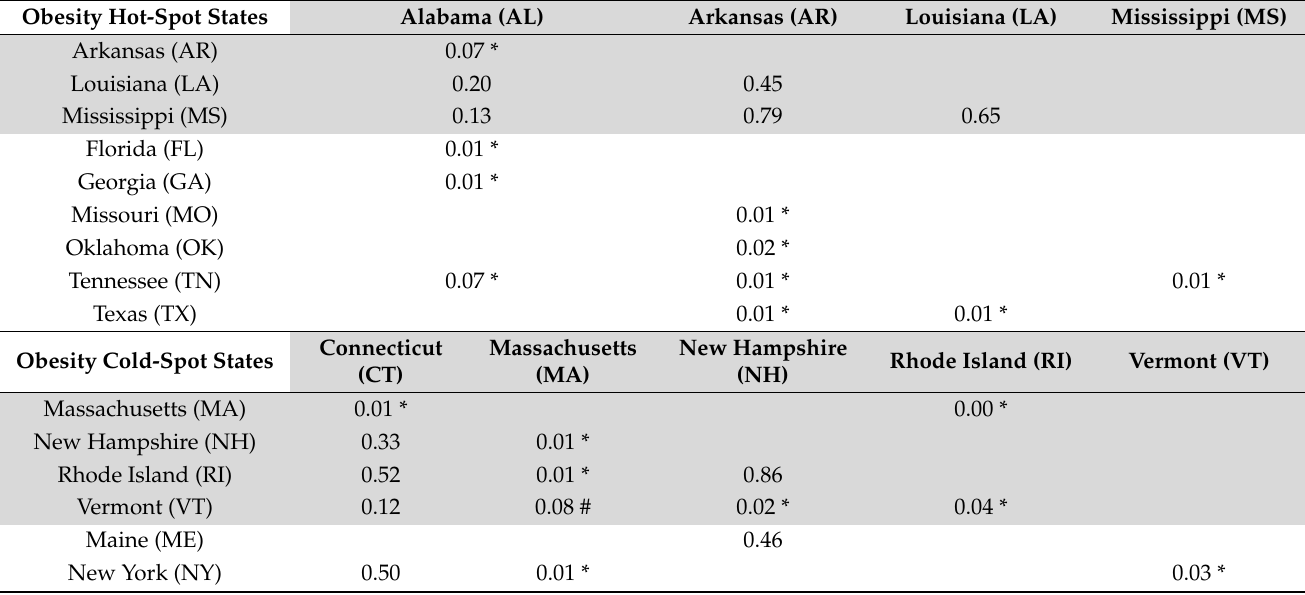
Table 2. Probabilities ( p -values) of having a t-value by comparing estimates between states within hot-spot or cold-spot clusters (shaded cells) and neighboring states (unshaded